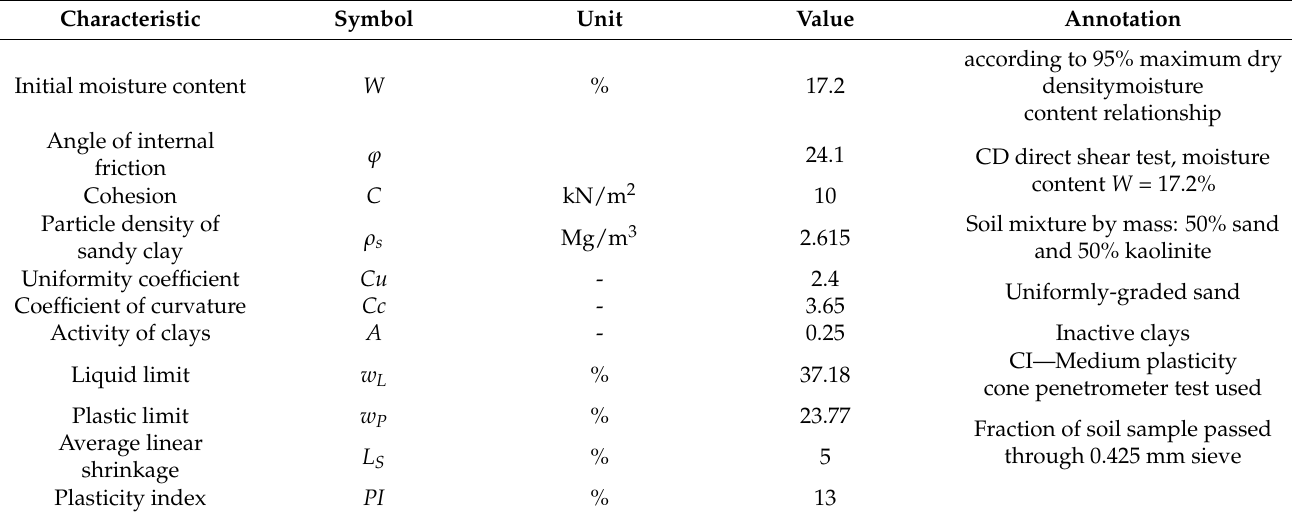
Table 2. Physical characteristics of soil